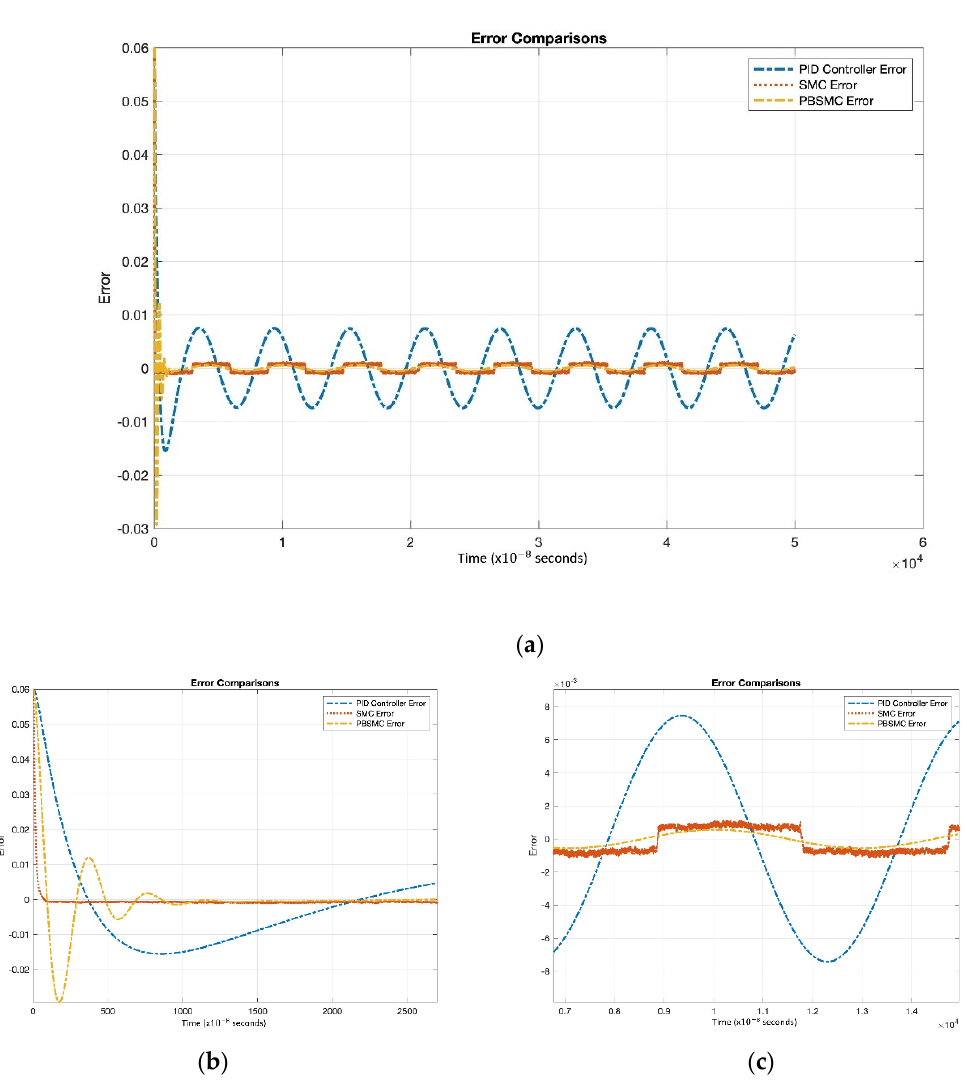
Figure 8. ( a ) Tracking Error Comparison, ( b ) Convergence Performance, ( c ) Steady-State Error Performance.